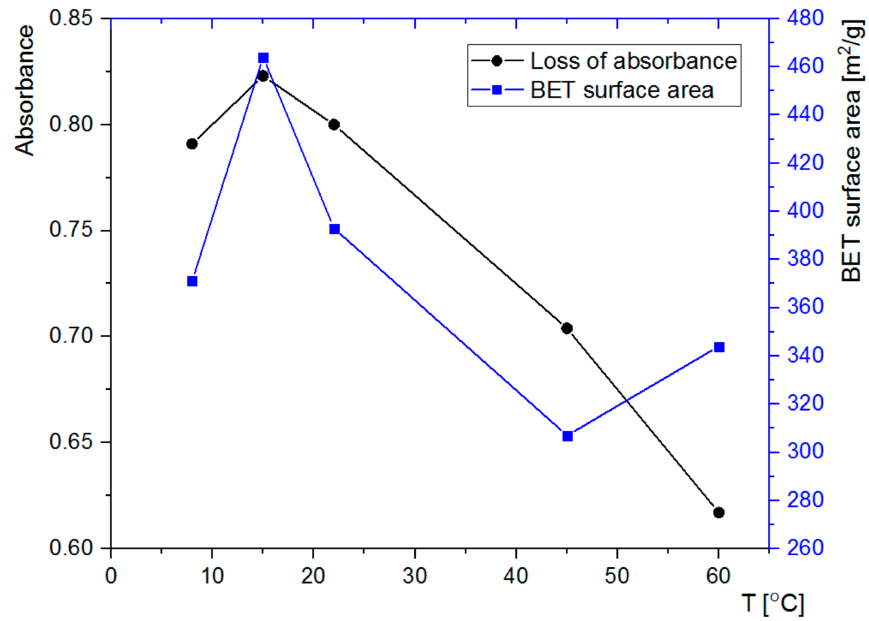
Figure 8. (Left axis) loss of absorbance (at ca. 527 nm based on the absorption spectra in Figure 7) of the Rh6G solution after adsorption of the dye in suspensions of SCMS-C particles, synthesized at various temperatures and BET surface areas (right axis) for the same